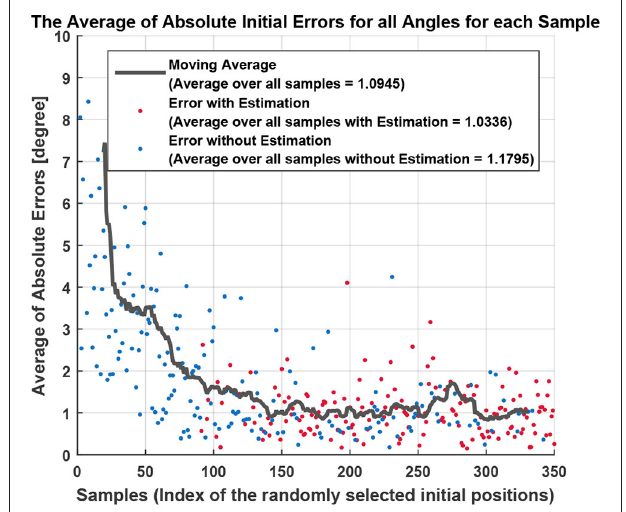
FIGURE 6 | The average of absolute initial errors of all desired angles are shown for all trials. The initial errors were shown separately for each angle before in Figure 5 . Depending on the the starting point (sample) the coordination parameters were provided either by the closest trained neuron to the sample, in blue, or by an estimation using IDW (11) among the surrounding neurons, in